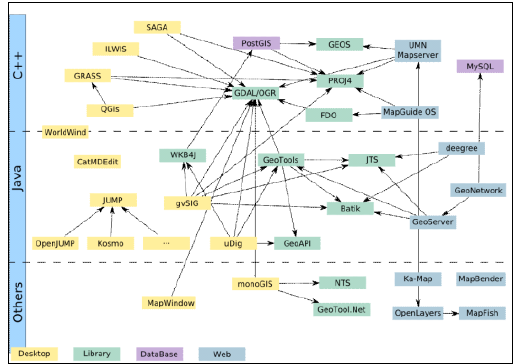
Figure 2 Relationships between FOSS4G Projects (Sanz-Salinas and Montesinos-Lajara, 2009)